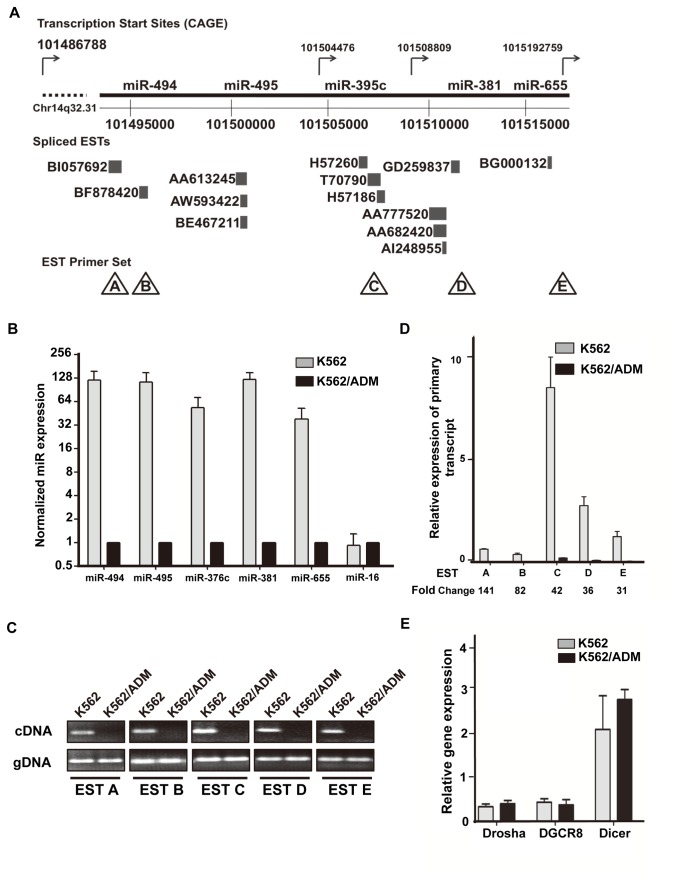
Expression of primary transcripts in the miR cluster on chromosome 14q32.31.(A) Schematic representation of known EST sites and selected miRs shown in UCSC genome browser (Human Feb. 2009 (GRCh37/hg19)) at chromosome region 14q32.31. EST primer sets A to E are indicated in triangles below each EST. Transcription start sites sourced from FANTOM CAGE tags are shown as arrows on the top of the 14q32.31 region. (B) Expression of selected miRs (miR-494, miR-495, miR-376c, miR-381 and miR-655) in K562 and K562/ADM cells was validated by stem-loop real-time PCR. The Ct values of these miRs were normalized to that of miR-425 whose level of expression was similar in the two cell lines. The relative expression of miR-494, miR-495, miR-376c, miR-381, miR-655 and miR-16 in K562/ADM cells was calculated. The results are shown as the mean ± SD of three independent experiments. (C) PCR products were resolved on a 2% agarose gel. (D) Expression of the primary transcripts in both K562 and K562/ADM was determined by RT-PCR using primers designed against ESTs A to E. The data were normalized to GAPDH. The results are shown as the mean ± SD of three independent experiments. Quantification of the change of expression level in K562/ADM cells relative to K562 cells is shown on the bottom. (E) Expression of three human RNA nuclease genes, Drosha, DGCR8 and Dicer, in both K562 and K562/ADM cells, was determined by real-time PCR. The expression values were normalized to GAPDH, and are shown as the mean ± SD of three independent experiments.